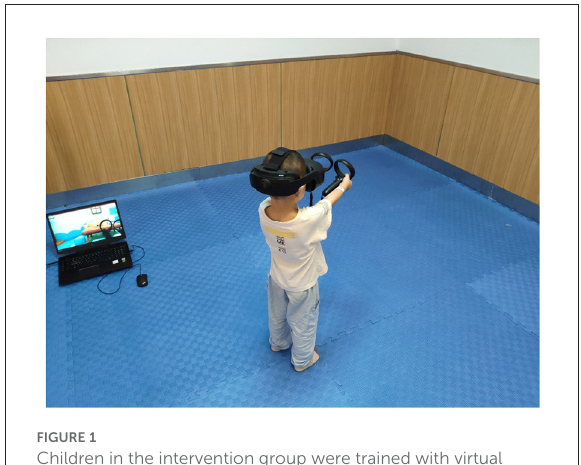
FIGURE1 Children in the intervention group were trained with virtual reality technology.